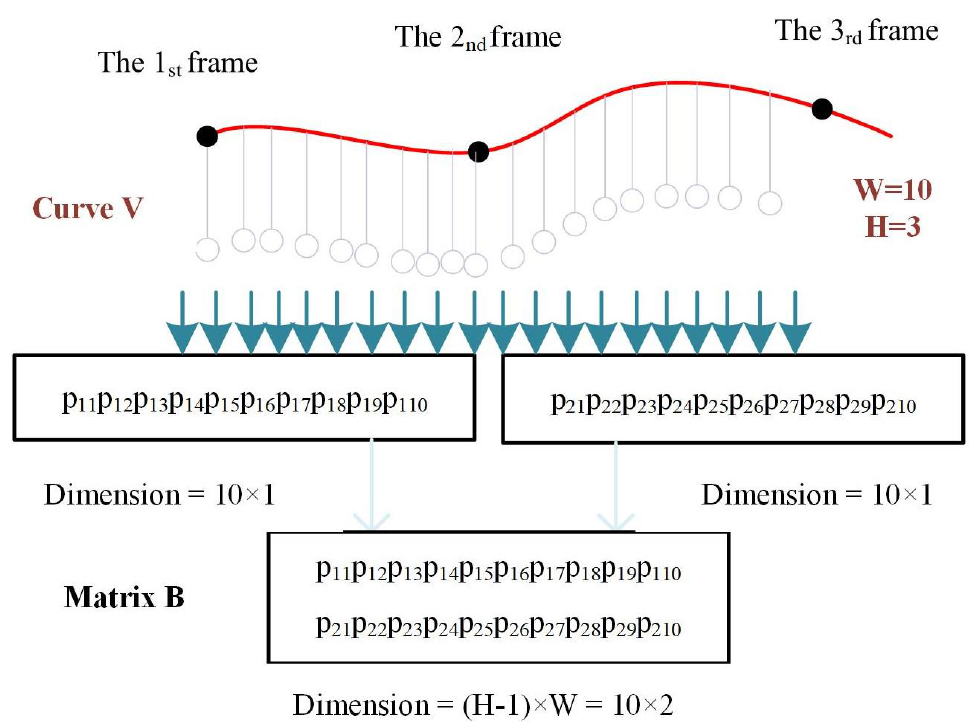
Figure 6. The construction of the matrices B . 10 points are sampled from every two adjacent frames, there are totally ( H − 1 ) × W points sampled from the curve. The sampled points are sorted into a matrix B ∈ R ( H − 1 ) × W . Algorithm 3 The matrix processing